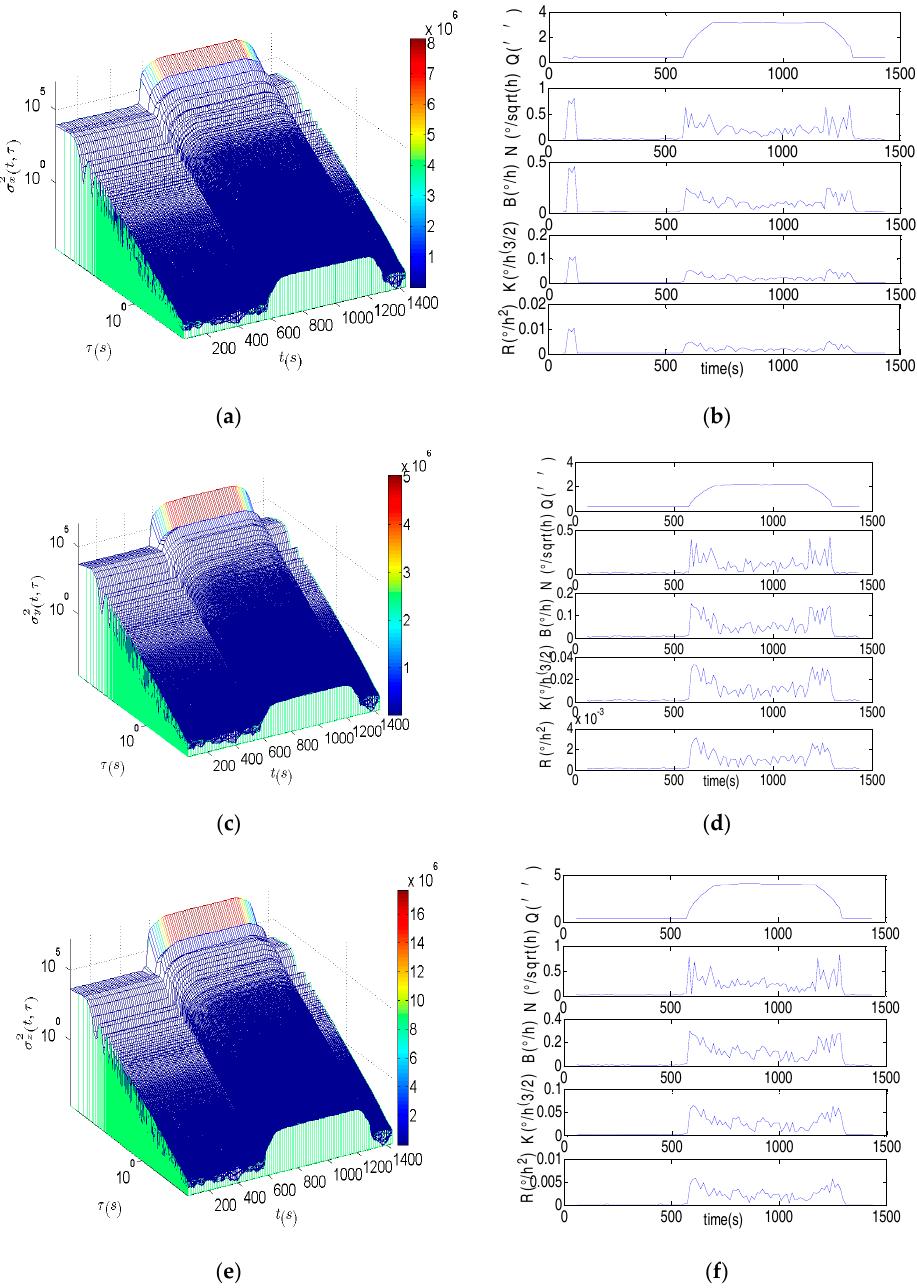
Figure 9. DAVAR and the noise terms in the random vibration test. ( a ) The DAVAR of the FOGX; ( b ) The coefficients of noise terms in FOGX; ( c ) The DAVAR of the FOGY; ( d ) The coefficients of noise terms in FOGY; ( e ) The DAVAR of the FOGZ; ( f ) The coefficients of noise terms in FOGZ.